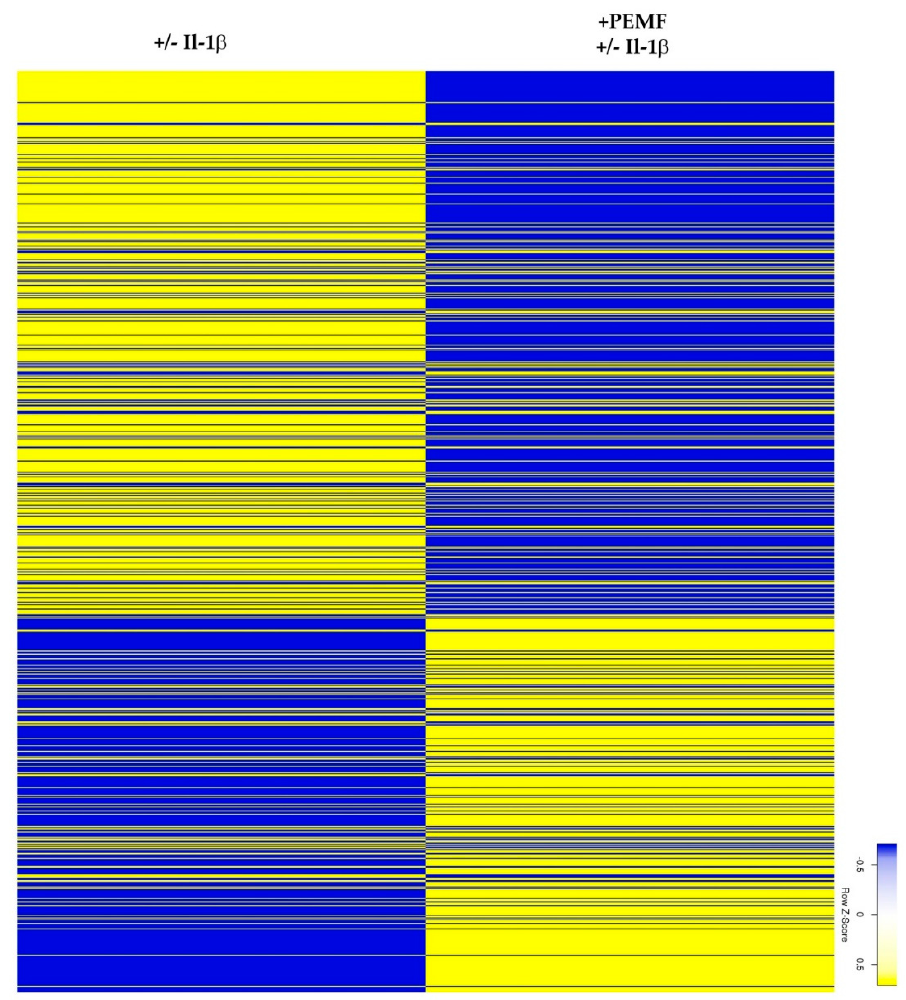
Figure 3. Unclustered heatmap of differentially expressed genes demonstrates global responses of 3D constructs after PEMF exposure ( ≥ 2.5-fold change; p value < 0.05).